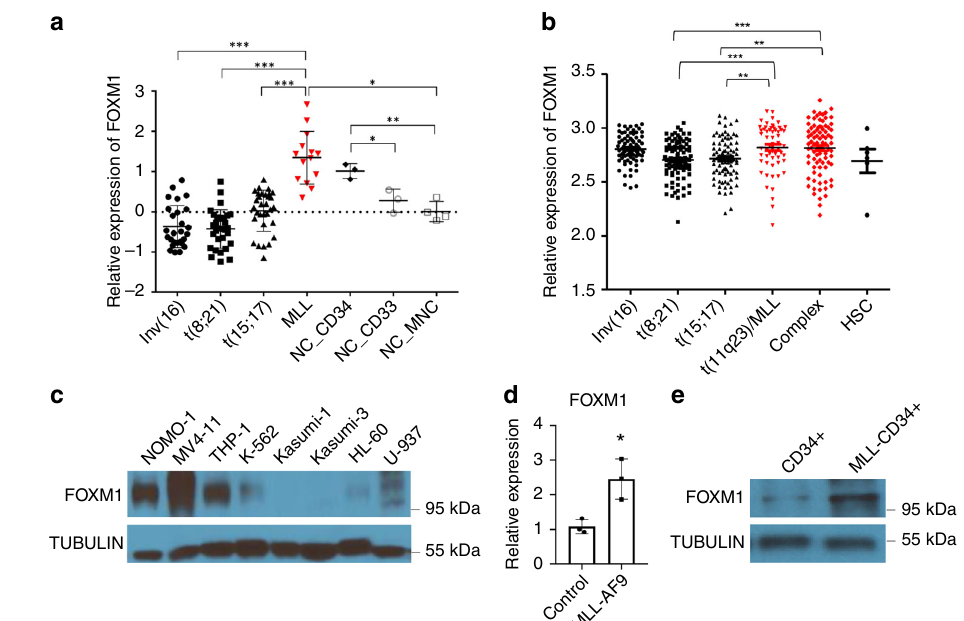
Fig. 1 FOXM1 is upregulated in MLL-r leukemia cells. a , b Comparison of FOXM1 expression among human primary AML cases with MLL rearrangements t(11q23) (MLL) and those without MLL rearrangements (non-MLL) AML cases. t(8;21), t(15;17), and inv(16) are AML subtypes. MLL leukemia includes MLL-AF4 and MLL-AF9. CD34 + HSPCs, CD33 + myeloid progenitors, and mononuclear cells (MNC) from healthy donors were used as controls. The expression values were log2-transformed and mean centered. The expression data ( a ) and ( b ) were described, respectively, in previous study 34 , and in other datasets of AML patients 35 . c Western Blot analysis of FOXM1 expression in human myeloid leukemia cells with different fusion genes. NOMO-1, MV4-11 and THP-1 harbored the MLL rearrangements translocation, which had relatively higher FOXM1 protein level compared to other non-MLL rearrangements cells. d , e FOXM1 expression in human CD34 + cells, which were isolated from cord blood, infected with control plasmid or MLL-AF9-YFP, as determined by quantitative(q)RT-PCR ( d ) or Western Blot analysis ( e ). The average expression level of FOXM1 in the CD34 + cells with control plasmid was set as 1 for qRT-PCR. TUBULIN served as the inner control for WB assay. * p < 0.05, ** p < 0.01, *** p < 0.001, mean ± s.d., t -test. Source data are provided as a Source Data fi